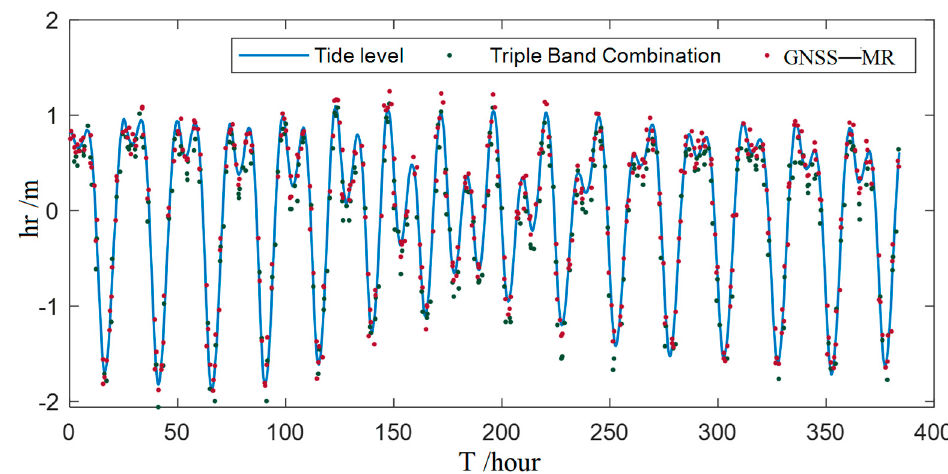
Figure 6. The tide level inversion method of the triple-frequency combined-phase observations, the tidal-level inversion results of the GNSS-MR technology, and the measured tide level change curve. The vertical axis h r represents the tide height; the horizontal axis T indicates the inversion time.